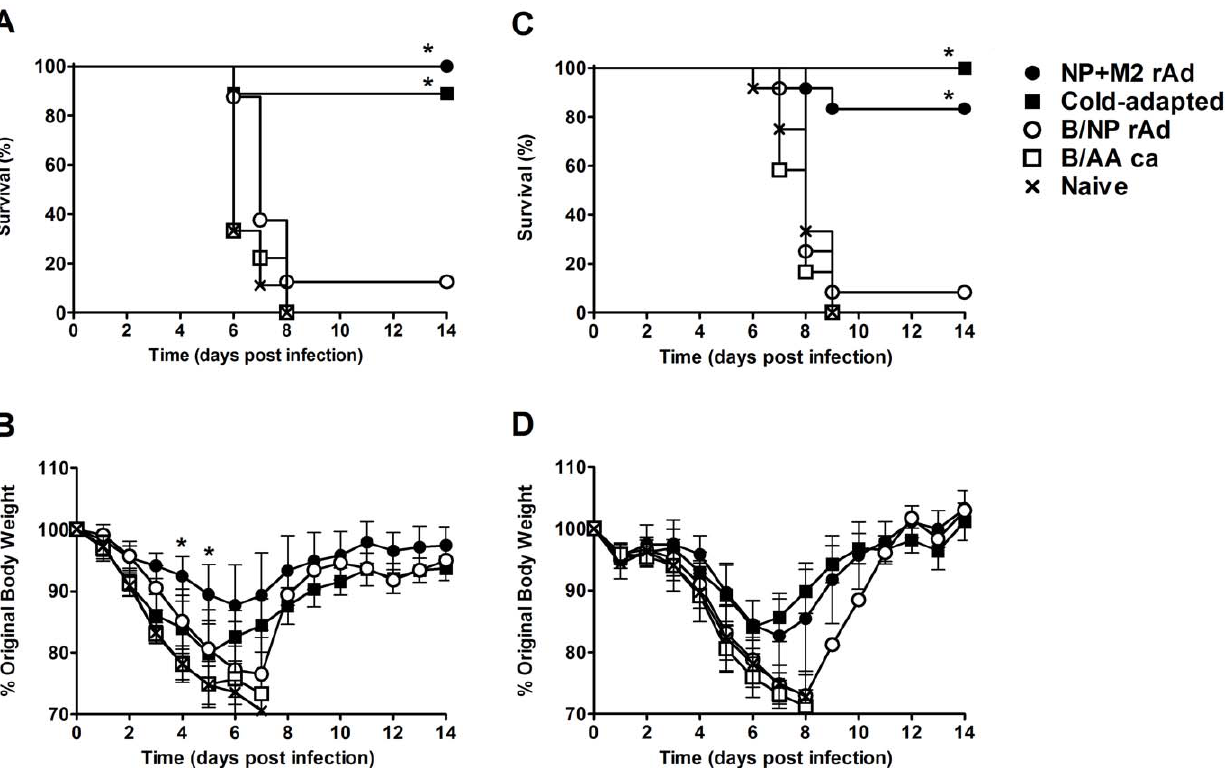
Figure 4. Weight loss and survival. Vaccine effectiveness in protection against challenge with ma-CA/04. Groups of BALB/c (A and B) or B6 (C and D) mice were immunized as in Figure 1, or left unvaccinated. Three weeks after immunization, animals were challenged with 5 MLD 50 of ma-CA/04 intranasally and monitored for survival (A and C) and weight loss (B and D). Weight loss graph shows average of n=9 (BALB/c) or n=12 (B6) mice 6 SD. * P # 0.0001 versus naı¨ve; log rank test (A and C); or P # 0.01 versus naı¨ve; two-way repeated measures ANOVA with Holm-Sidak post-test (B and D). No statistically significant differences were found between NP + M2-rAd and ca vaccine.